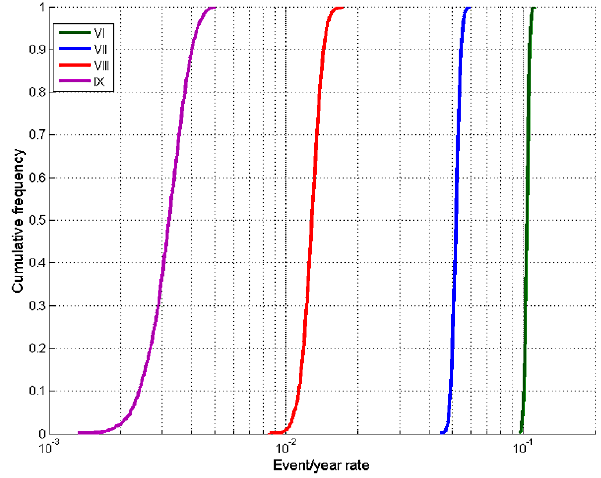
Figure 5. ECDF of the activity rates for four intensity classes.